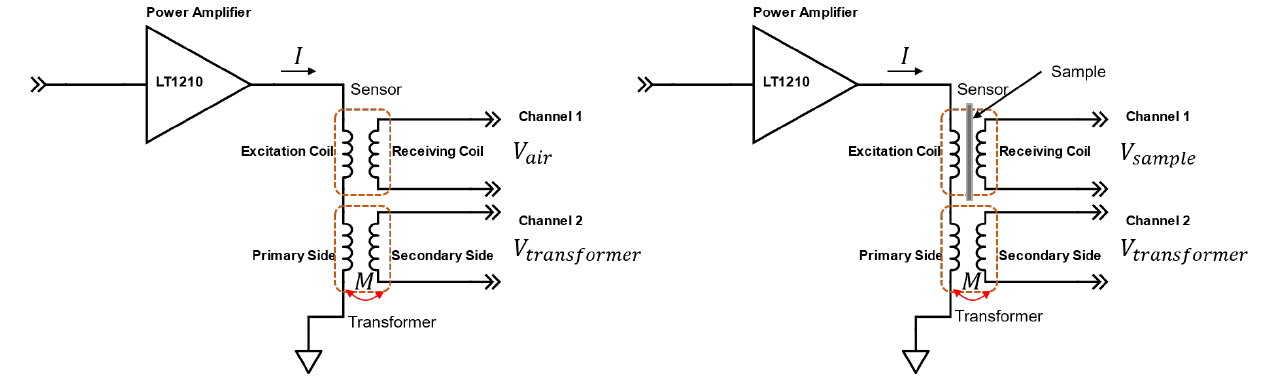
Figure 13. Calibration with a current sensing transformer.